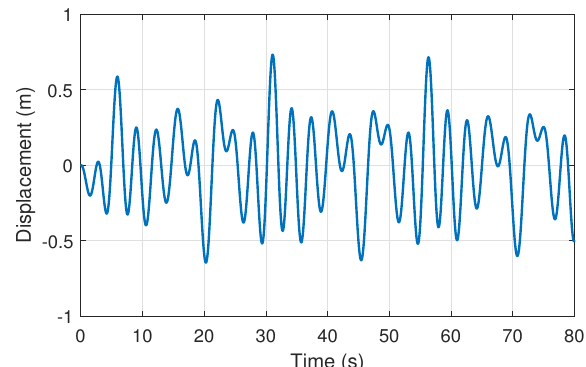
Figure 3. Displacement of the structure without control.